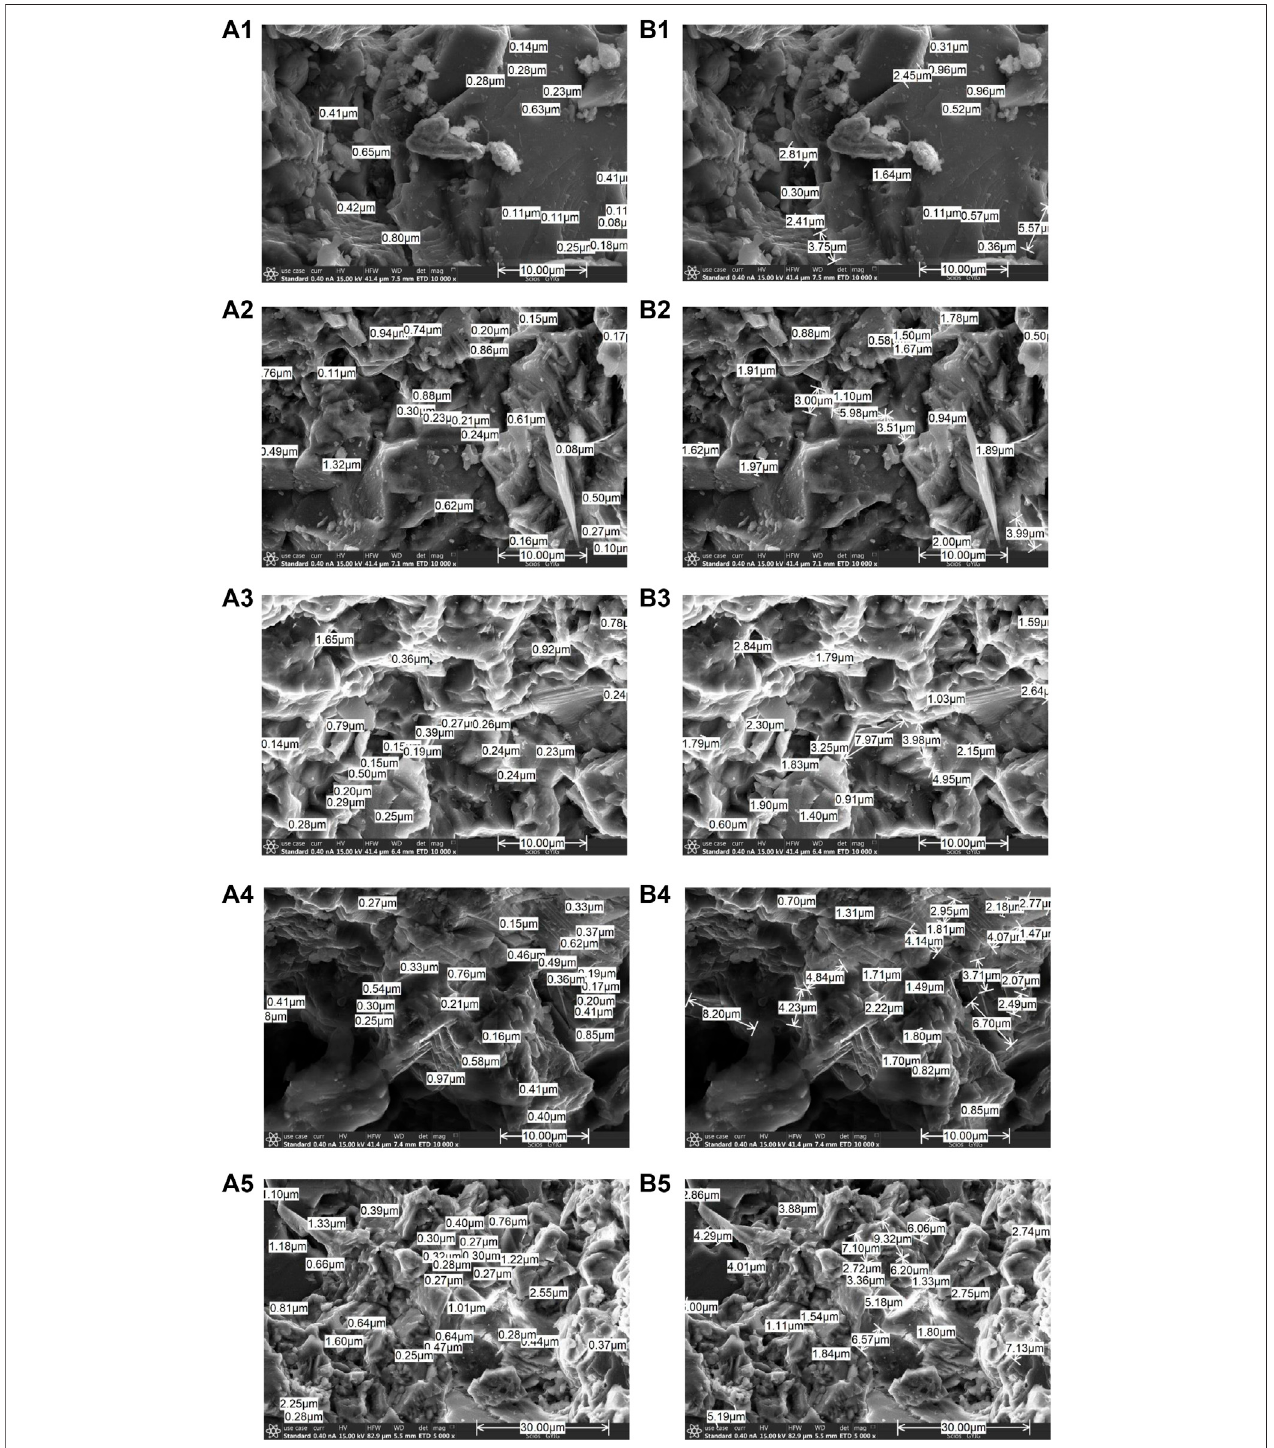
FIGURE5| Microstructureofjointedlimestonewithdifferentwatersaturationtimes. (A1 – A5) :Crackwidthoflimestonesamplesdriedandsaturatedfor1,3,5and 7 days. (B1 – B5) : Crack length of limestone samples dried and saturated for 1, 3, 5 and 7 days.